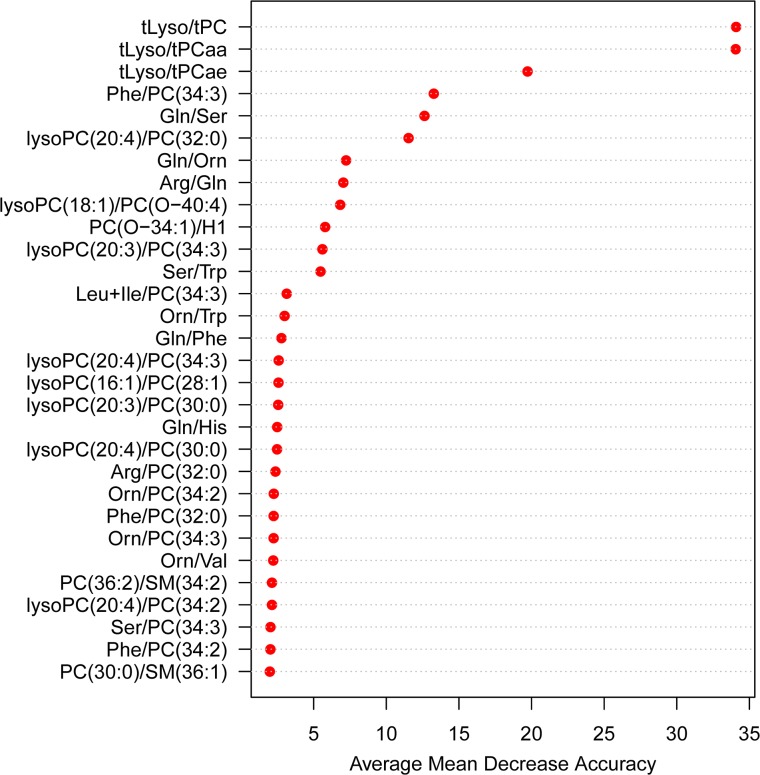
Metabolite ratio importance plot.The importance for each metabolite ratio in classifying samples into ‘good’ or ‘bad’ pre-storage handling conditions was assessed by the average decrease in classification accuracy found in 500 Random Forest analysis iterations (the full names of the metabolites can be found in S1 Table).